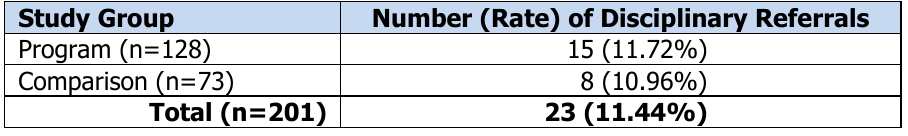
Disciplinary Referrals Prior to Implementation of Healing Species